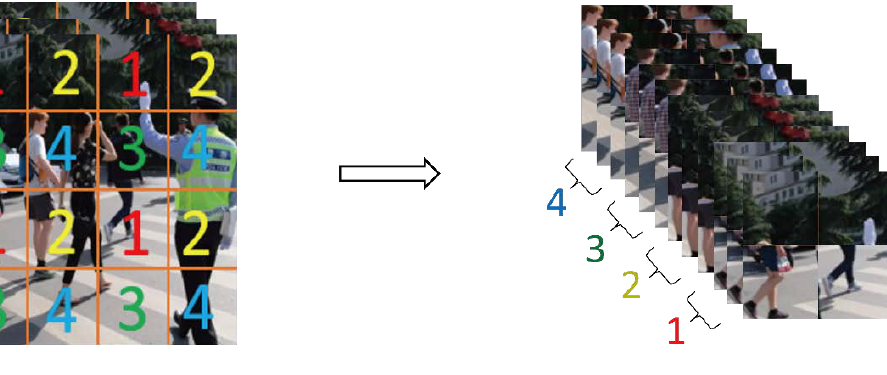
Figure 2. Focus structure diagram.